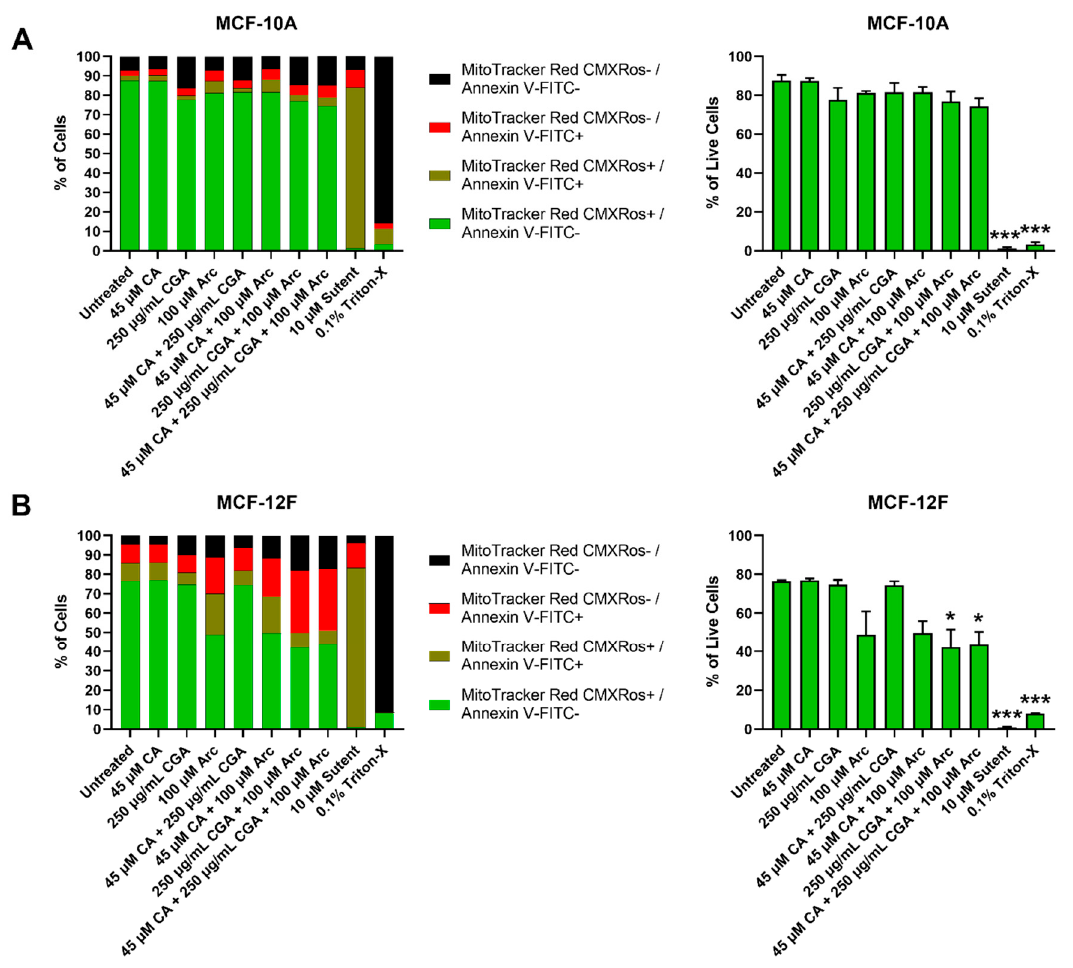
Figure 7. Cell death and live cell percentages in ( A ) MCF-10A and ( B ) MCF-12F normal mammary epithelial cells treated with CA, CGA, and Arc, alone or in combination, for 96 h. Green bars represent cells that are ∆Ψ m-positive and annexin V-negative (live cells); brown bars denote cells that are ∆Ψ m-positive and annexin V-positive (early cell death); red bars show cells that are ∆Ψ m-negative and annexin V-positive (late cell death); black bars represent cells that are ∆Ψ m-negative and annexin V-negative (late cell death). Each green bar in the % live cell graphs represents the mean of means ± SEM from 3 biological and experimental replicates ( n = 3) showing the percentage of live cells at 96 h. Twenty-four-hour 10 μ M Sutent treatment was used as a positive control for Annexin V-FITC and 30 min 0.1% Triton-X treatment was used as a double-negative staining control. The groups were compared using a one-way ANOVA. Differences in the percentage of live cells between groups were considered significant at p ≤ 0.05. Statistical significance compared to untreated: * = p < 0.05; *** = p < 0.001.